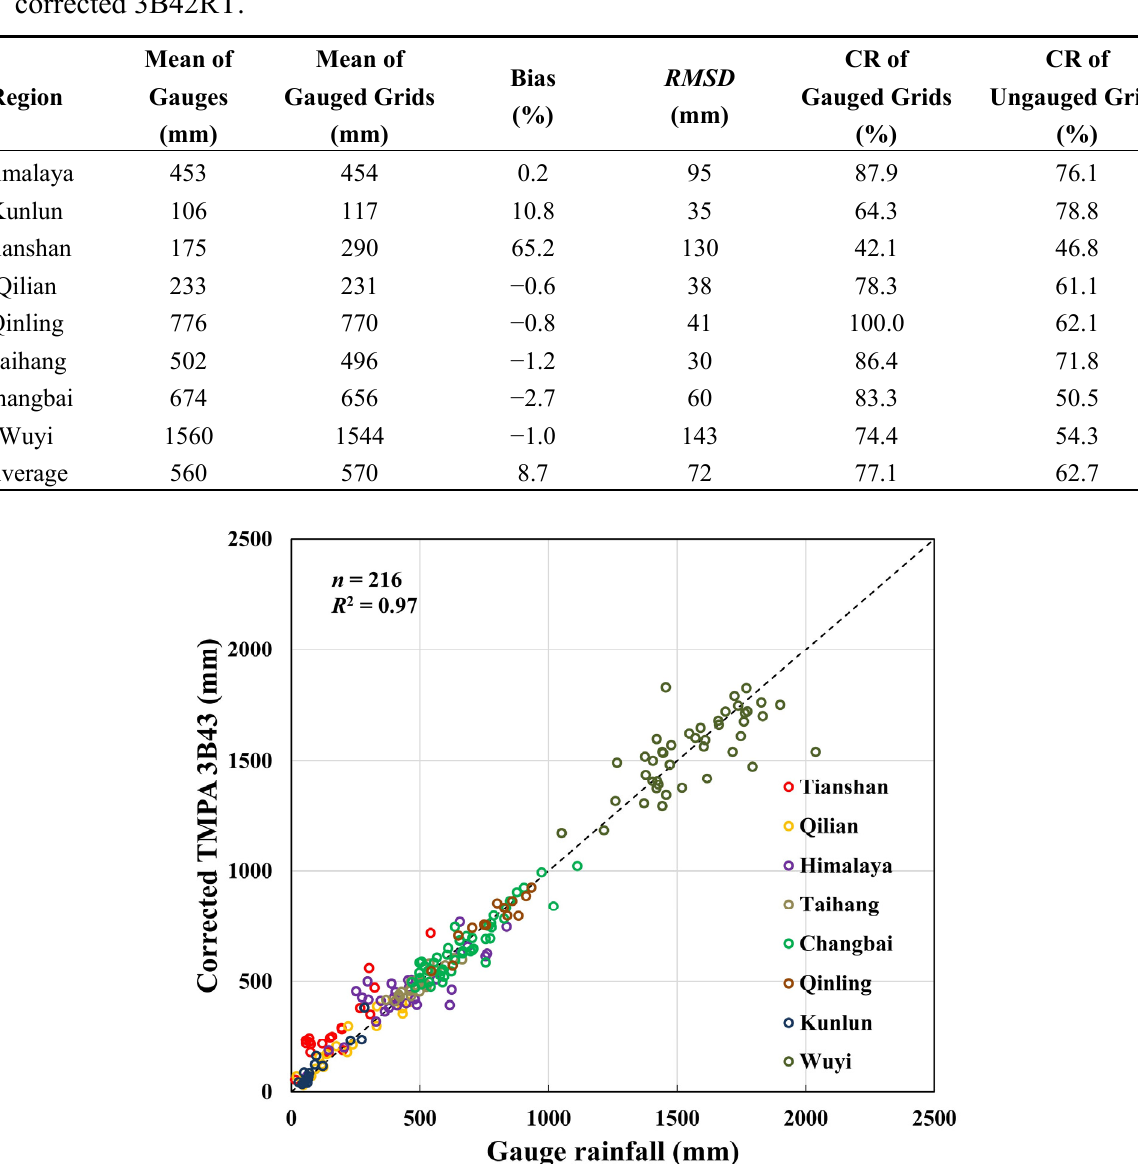
Figure 9. Validation of the mean annual rainfall (2001–2012) from gauge measurements and corrected